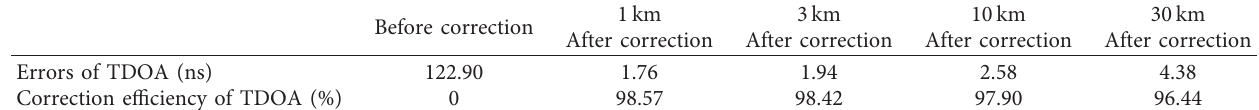
Table 2: TDOA correcting accuracy at the target with longer distance.